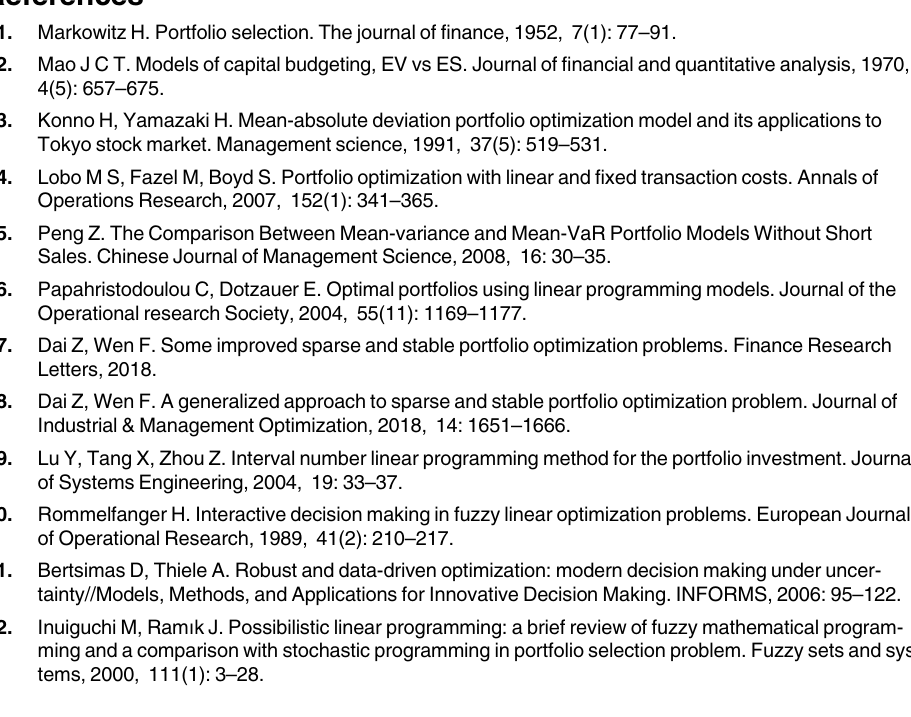
S1 Table. The intervals of expected rate of return. S2 Table. The intervals of variance and covariance risk (Unit /10 − 4 ). S3 Table. The turnover rate